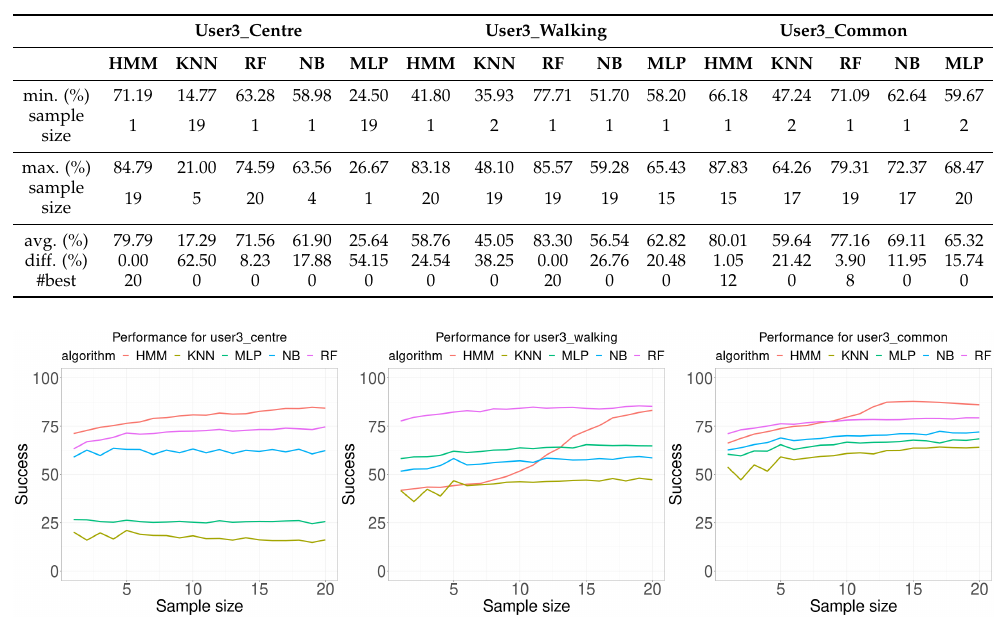
Figure 9. Performance comparison for user 3. Each curve plots the successful rate (percentage) as a function of the number of consecutive samples used for classification (sample size). Each Wi-Fi database contained 100 samples per room for building the